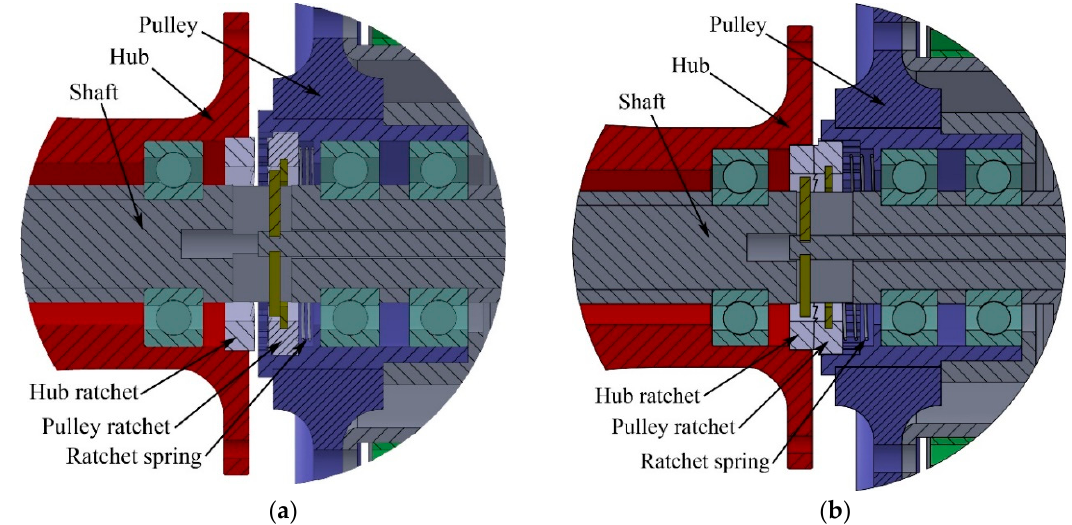
Figure 8. Particulars of the mechanism in the ( a ) Classic configuration; ( b ) Innovative configuration.